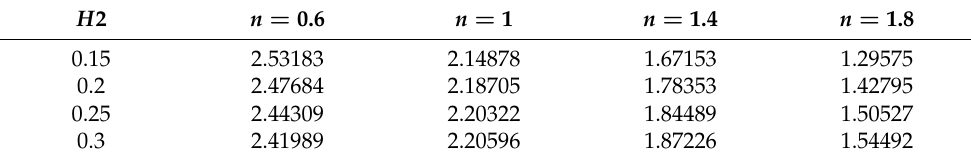
Table 13. The values of the average Nusselt number ( Nu avg ) at the solid-fluid interface.